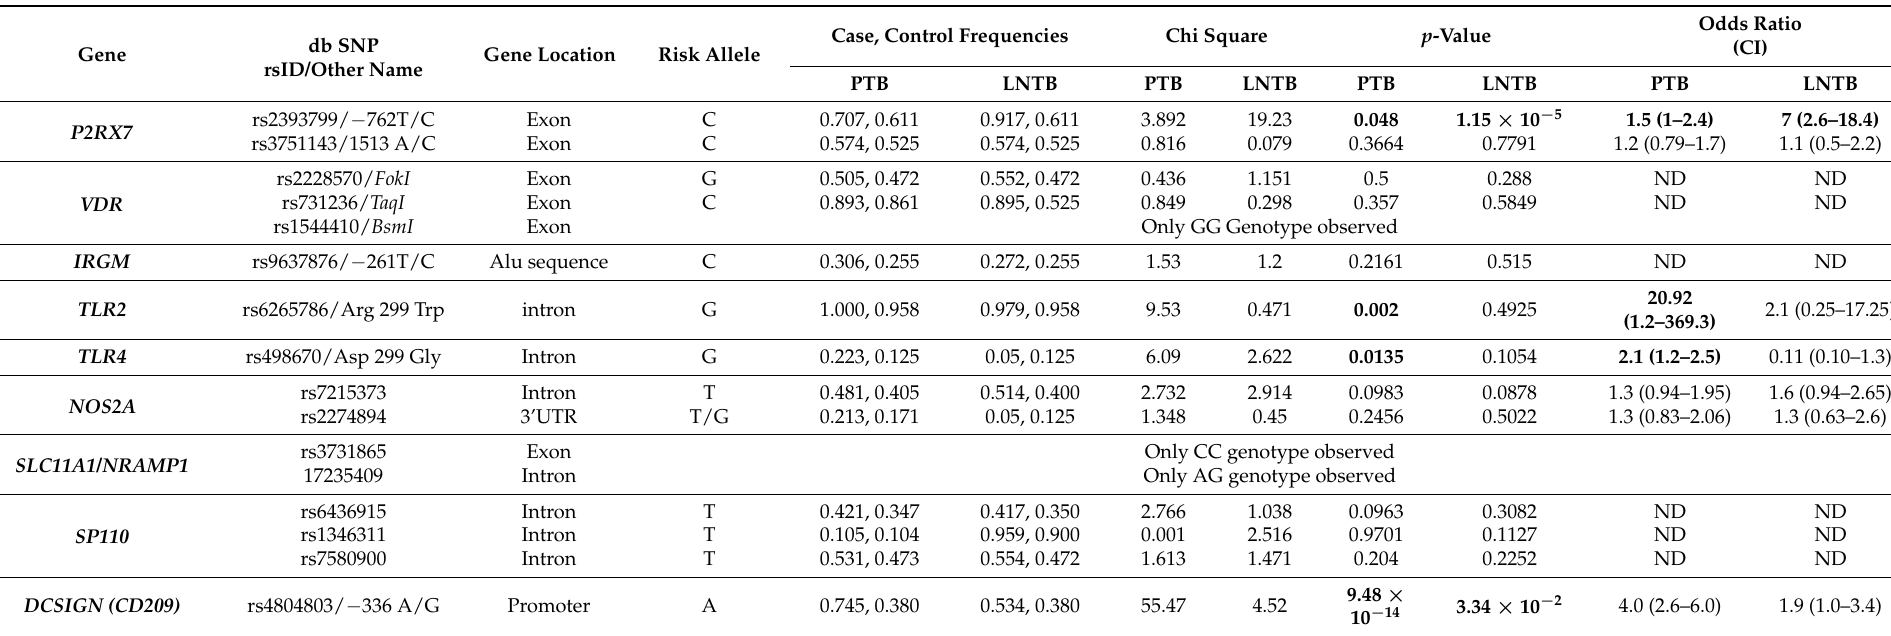
Table 5. Comparative Allelic association between various innate gene polymorphisms between PTB and